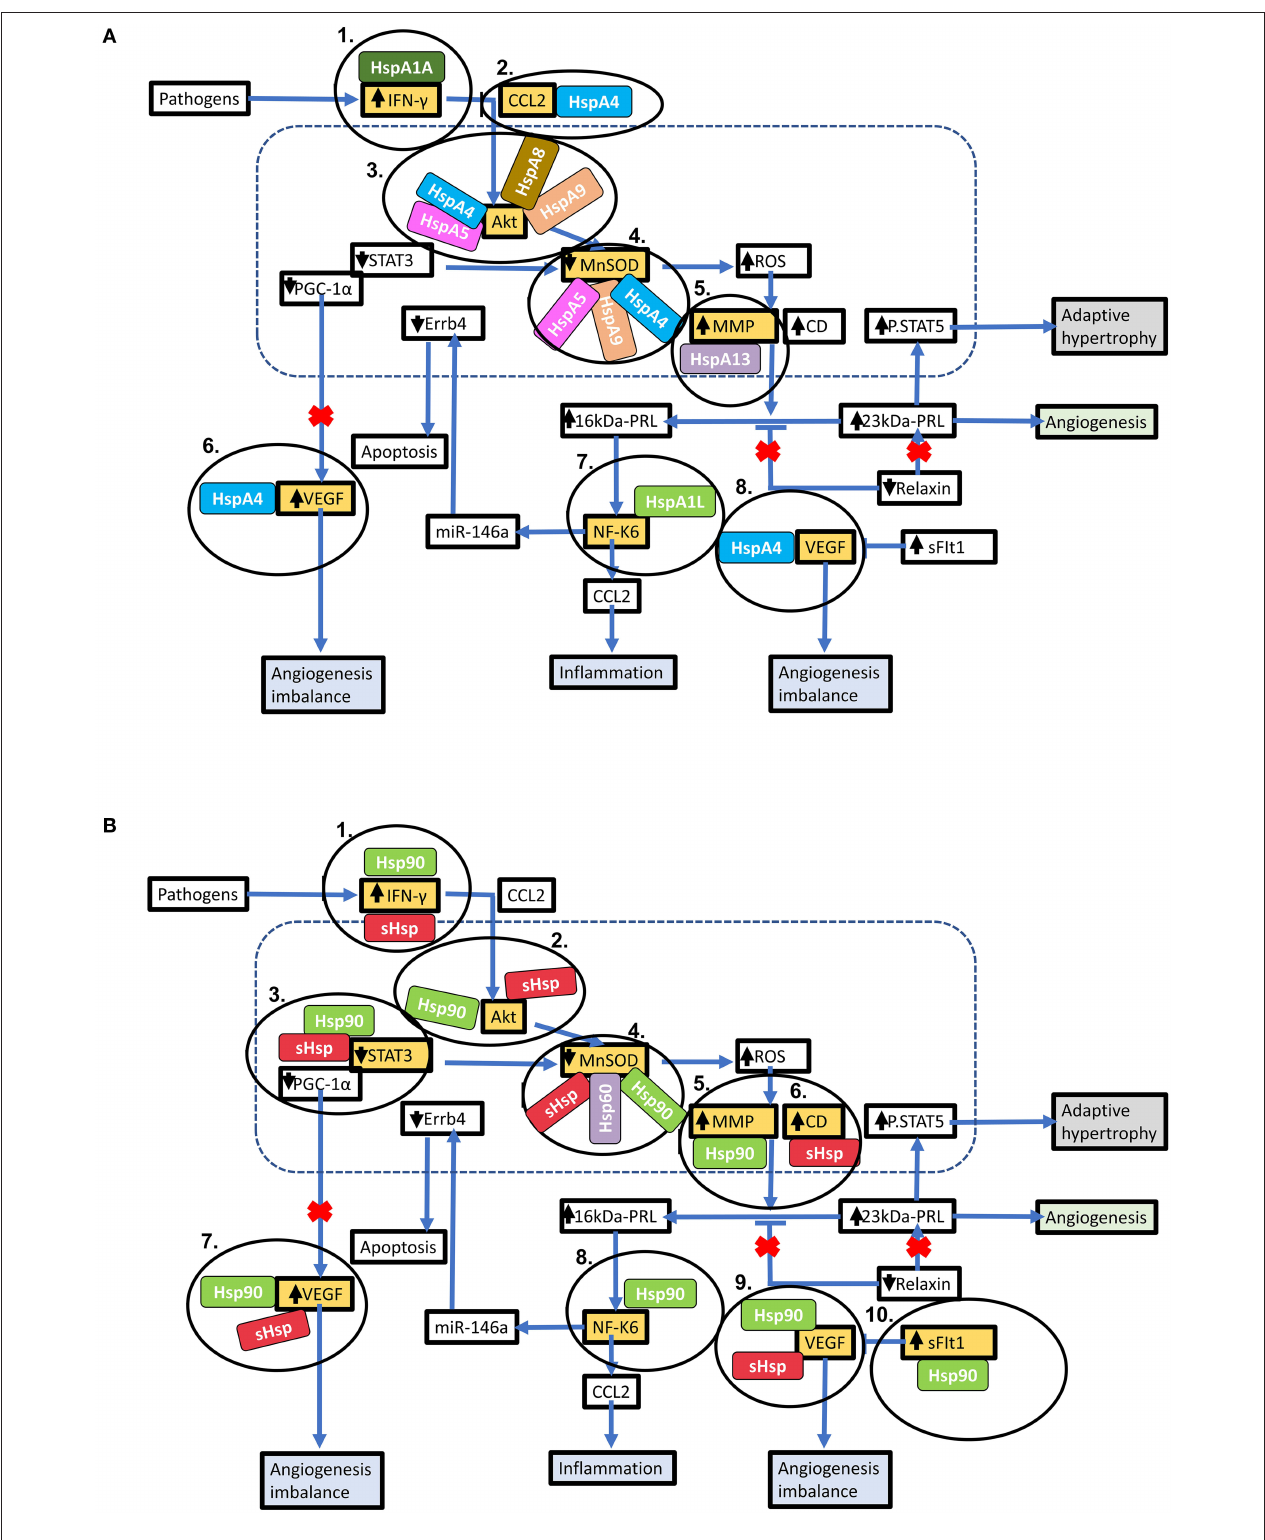
FIGURE 5 | Key stages in the PPCM pathophysiology pathway which are modulated by Hsps. Hsps interact with several proteins involved in the PPCM pathophysiological pathway. (A) Several Hsp70 isoforms interact with various proteins involved in PPCM pathogenesis. (B) The stages within the PPCM pathophysiology pathway where Hsp90 and sHsps interact with PPCM proteins are shown. Targeting these stages may be crucial in novel PPCM interventions.